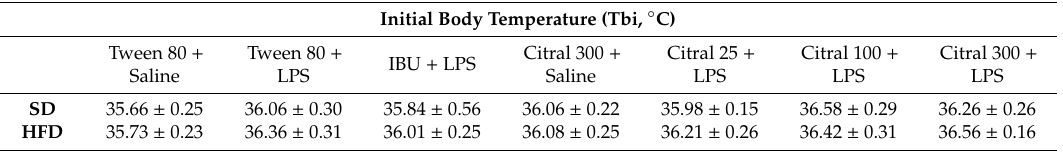
Table 3. Initial body temperature (Tbi) of animals fed with standard diet (SD) or high-fat diet (HFD) 60 min before the LPS-induced Systemic Inflammation (SI).